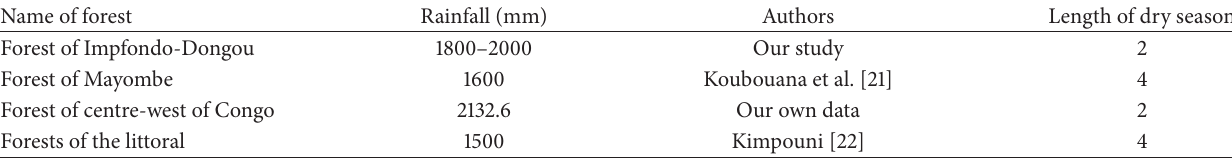
Table 4: The characteristics of ecological factors in some forests of Republic of